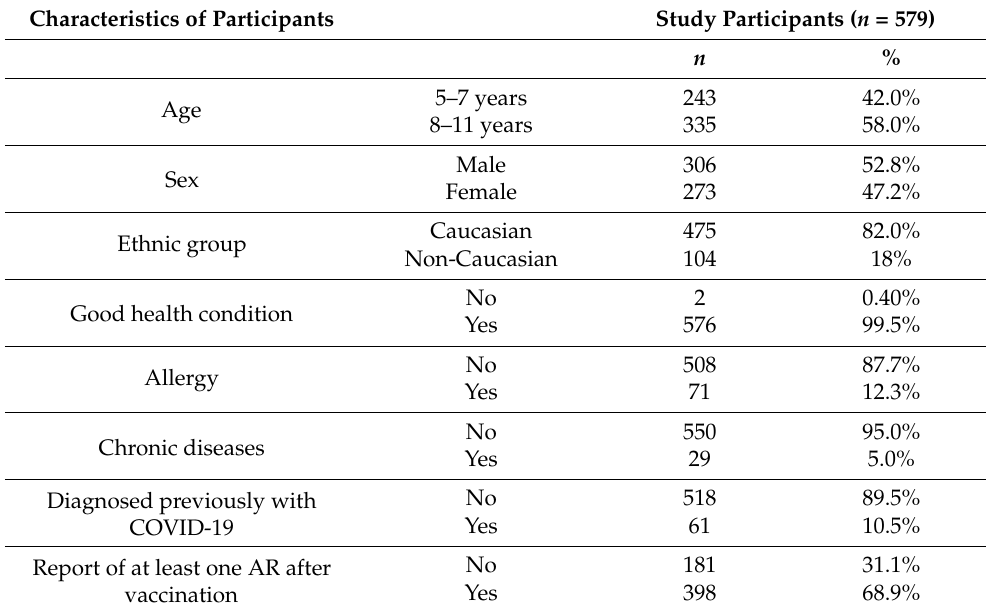
Table 1. Demographic and clinical characteristics of enrolled children.